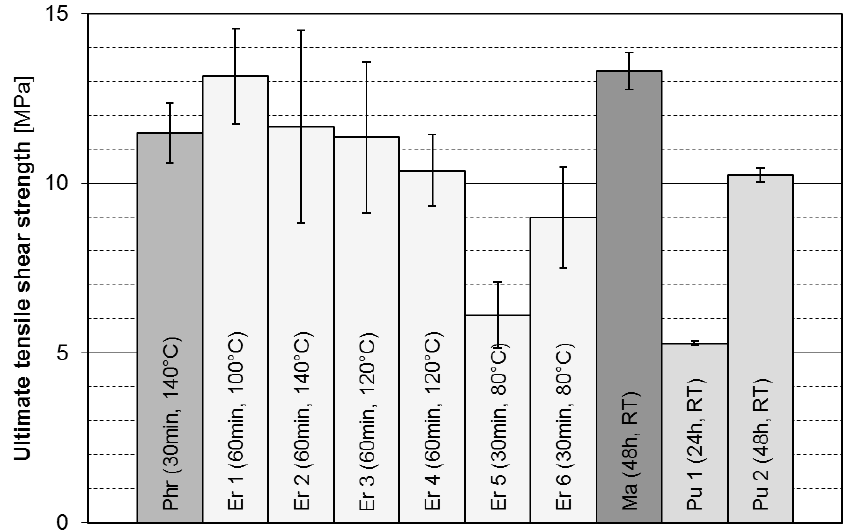
Figure 6. Creep behavior of different adhesives relative to bonding length (film